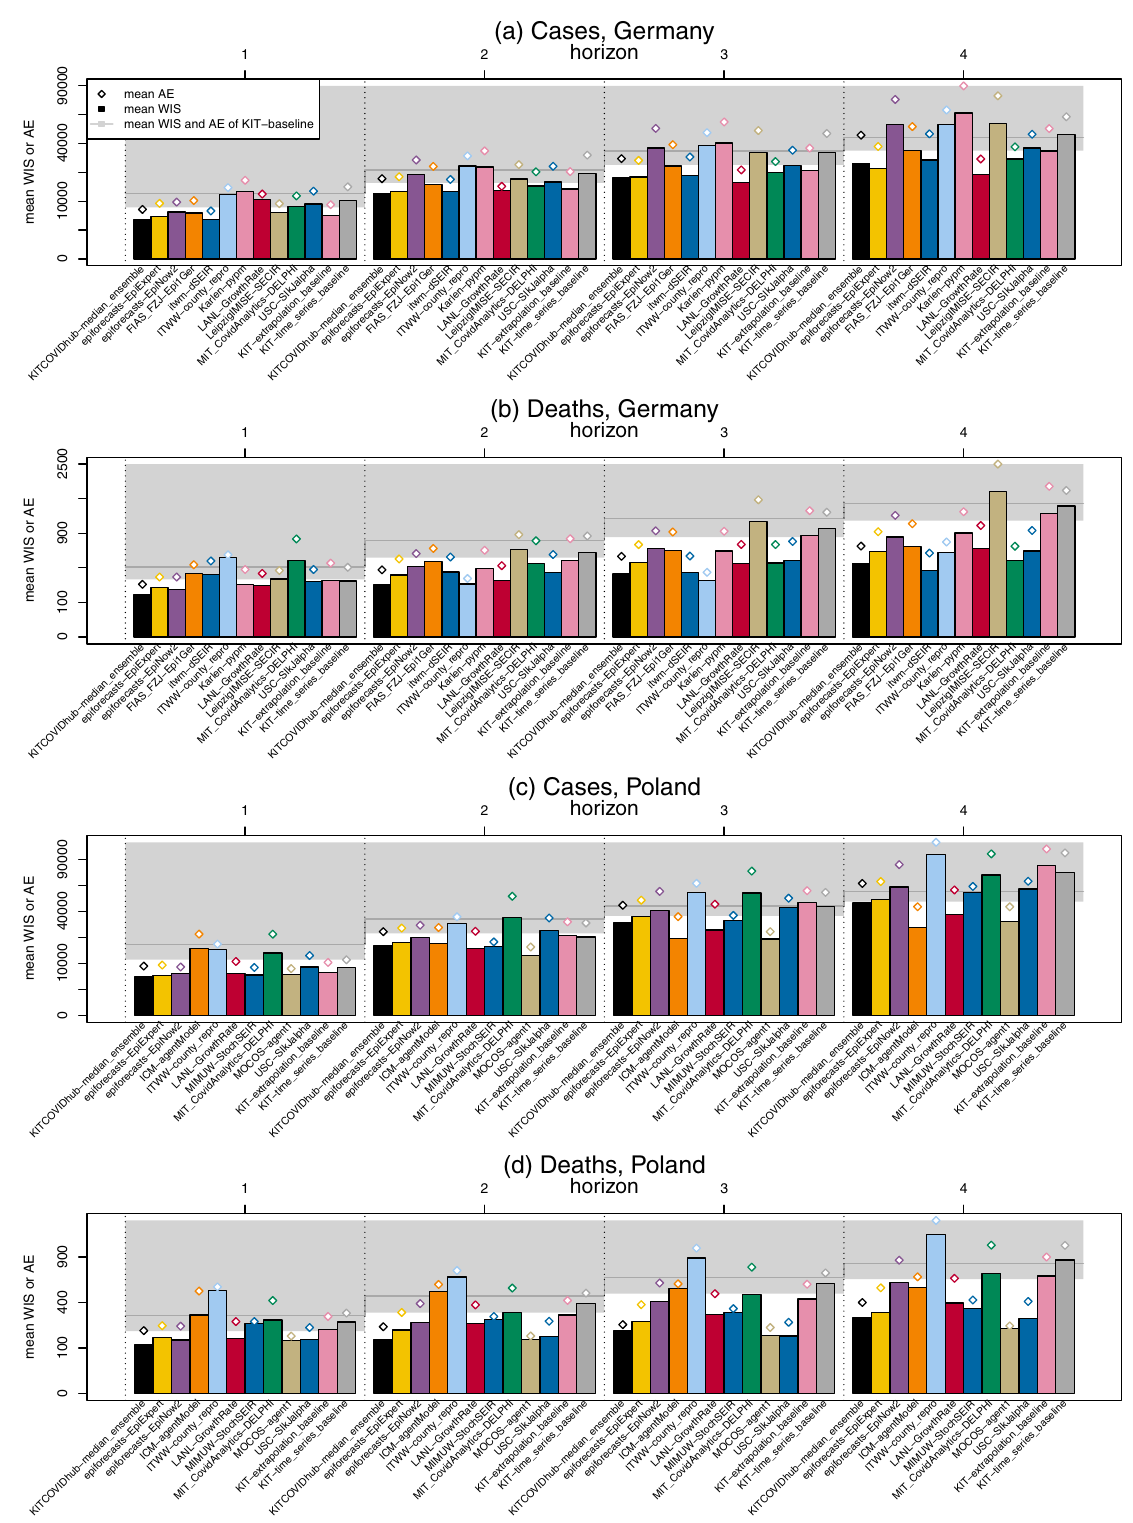
Fig. 4 Formal evaluation results in terms of mean weighted interval scores. Average weighted interval scores (bars) and absolute errors (diamonds) achieved by models in Germany ( a , b ) and Poland ( c , d ) per target and forecast horizon (12 weekly forecasts). The bottom end of the gray area represents the mean WIS of the baseline model KIT-baseline, and the gray horizontal line is its mean absolute error. Values are shown on a square-root scale to enhance readability. Only models covering all four horizons are